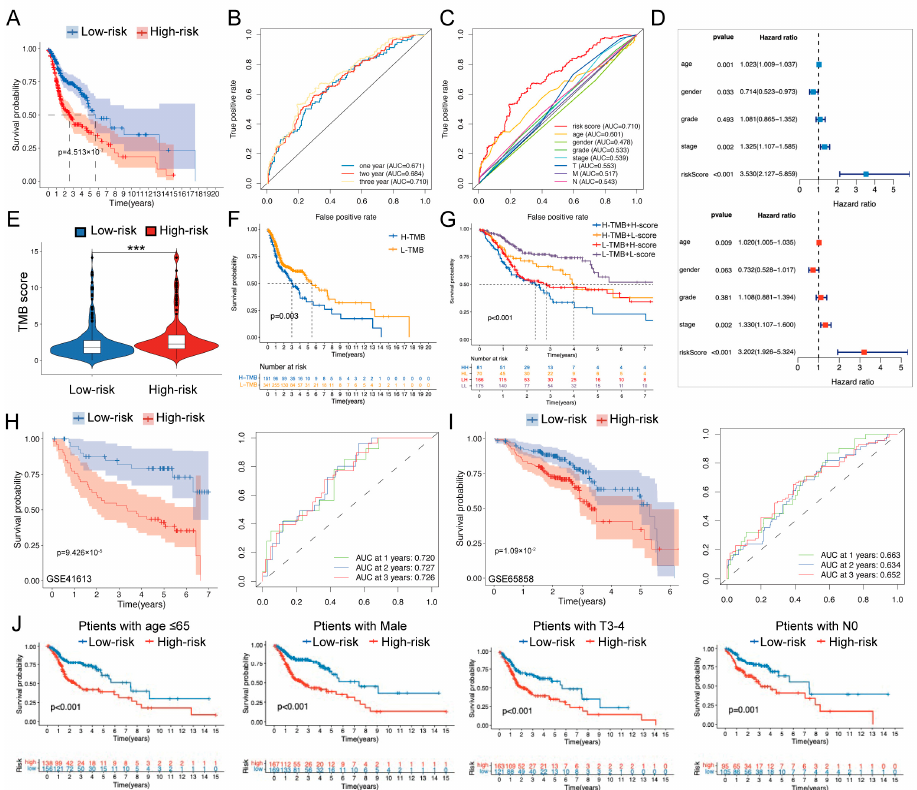
Figure 5. Prognosis prediction and validation. ( A ) Kaplan–Meier survival analysis for low- and high-risk groups. ( B ) ROC curves to predict the sensitivity and specificity of one-, two-, and three- year survival times based on the risk score. ( C ) ROC curves to compare the prognostic accuracy of risk score, age, gender, grade, tumor stage, and TNM in three-year survival time. ( D ) Univariate (up) and multivariate (down) Cox analyses to evaluate whether the risk score was an independent prognostic factor. ( E ) TMB score of two risk groups. ( F ) Kaplan–Meier survival analysis of the high- and low-TMB score groups. ( G ) Kaplan–Meier survival analysis for patients stratified by both TMB and risk scores. ( H ) Validation of survival analysis in GSE41613. ( I ) Validation of survival analysis in GSE65858. ( J ) Analysis of OS based on risk scores stratified by age, gender, and TNM stages in the TCGA-HNSCC cohort. ns, p > 0.05, * p < 0.05, ** p < 0.01, *** p <